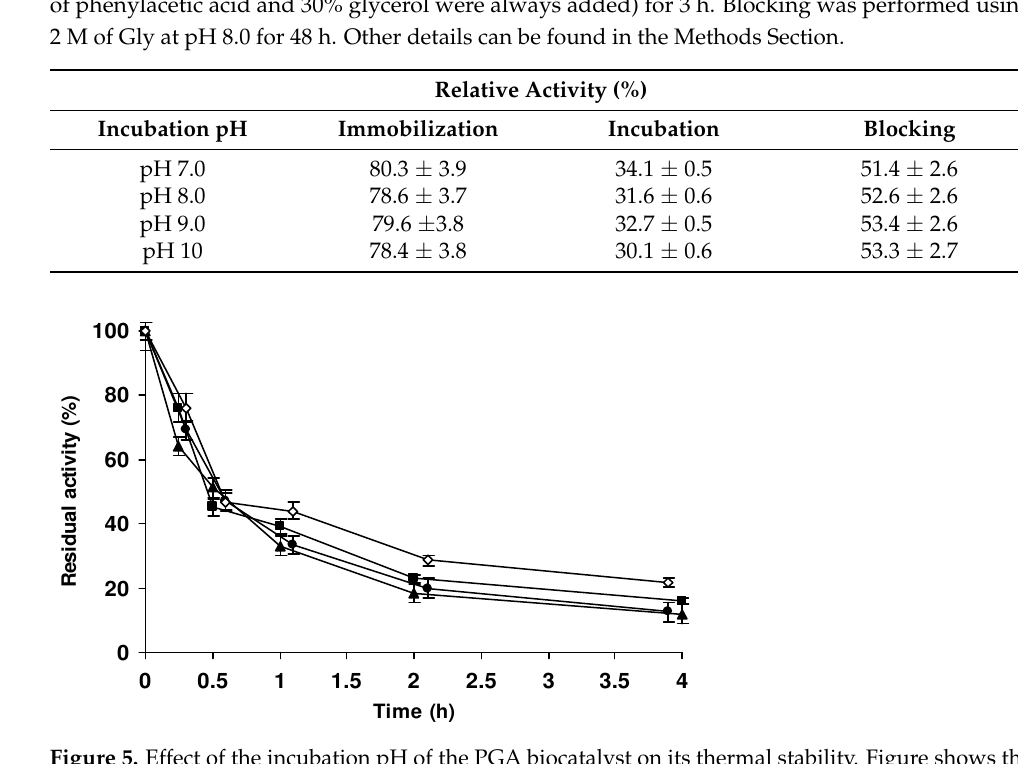
Table 4. Effect of the incubation time in the relative (considering 100% of the activity of the enzyme offered for the immobilization) hydrolytic activity of PGA biocatalysts immobilized in 5 mM of sodium phosphate at pH 7.0 and incubated in 25 mM of sodium carbonate (100 mM of phenylacetic acid and 30% glycerol) at pH 10.0. Blocking was performed with glycine. The experiments were conducted as described in the Methods Section.